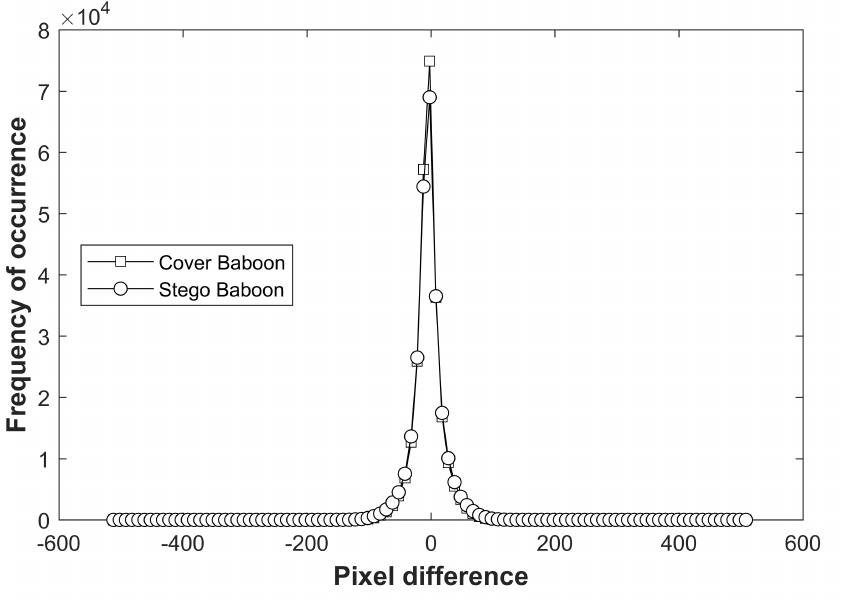
Figure 11. PDH plots of Lena for the proposed technique. Histogram analysis is also another method to detect the difference between stego and cover image. Histograms are frequently used in statistics to show the frequency of a particular type of variable within a given range. Figures 13 and 14 show the histogram analysis of the original images and associated stego images, respectively. As a result, it can be inferred from the outcomes of these experiments that the differences between cover and stego are small and the proposed technique is robust enough to defend against attacks on implanted data.